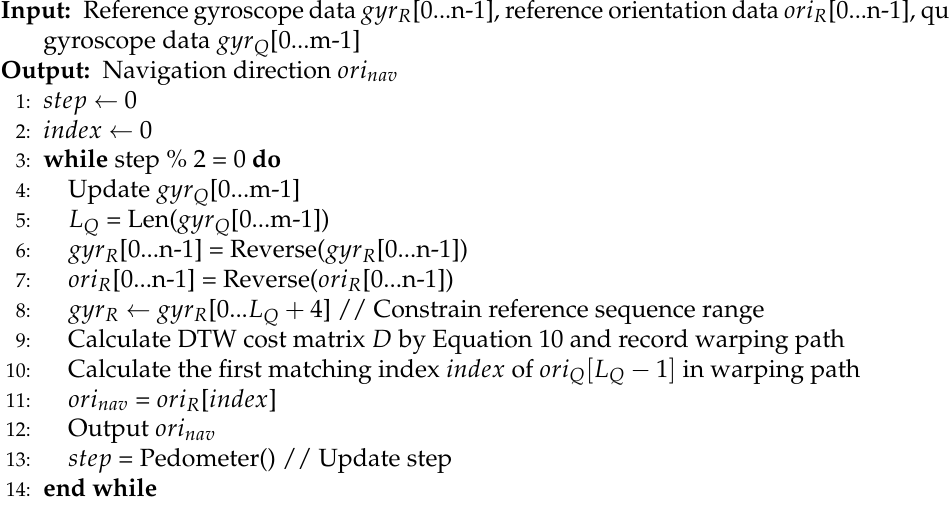
Figure 7. Gyroscope data sequence matching. The blue line represents the reference sequence, the black line represents the query sequence, and the dotted line represents the similar points between two time series. Algorithm 1 DTW algorithm with step count